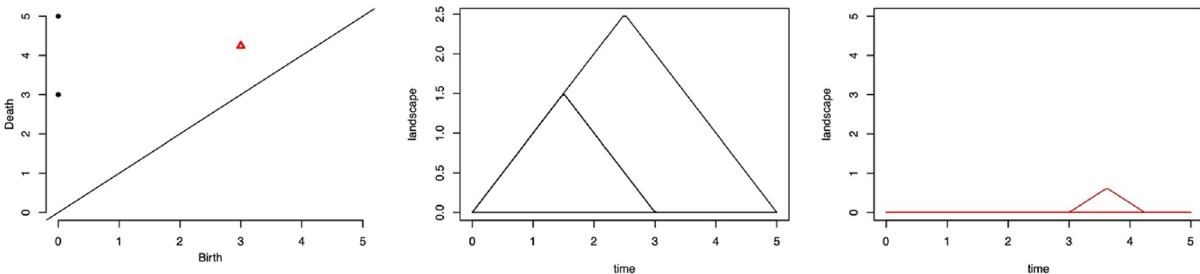
Figure 3. Topological summaries of the point-cloud data in Fig. 2—persistence diagram (left) and persistence landscape for connected components (middle) and holes